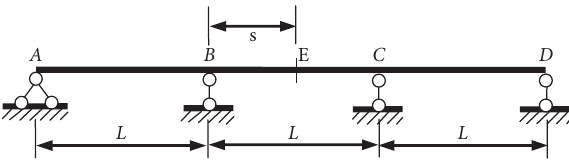
Figure 23: Three-span continuous girder model.